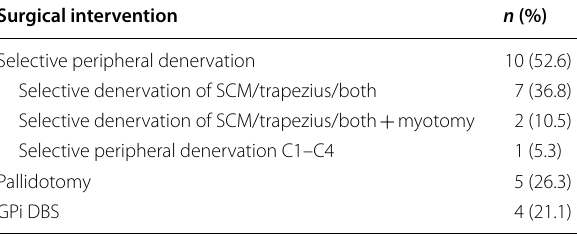
SCM sternocleidomastoid, GPi globus pallidus internus